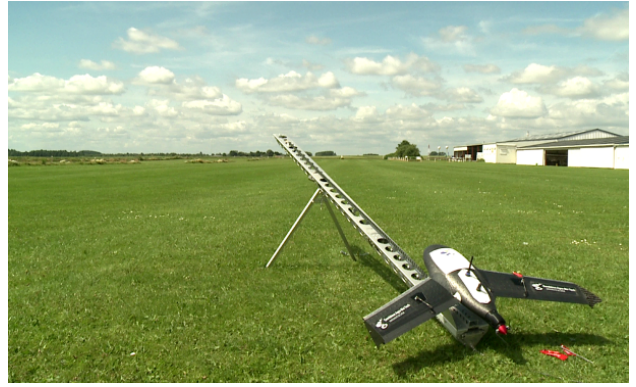
Figure 1. The small unmanned aerial system (UAS) Gatewing X100 on its launcher, ready for